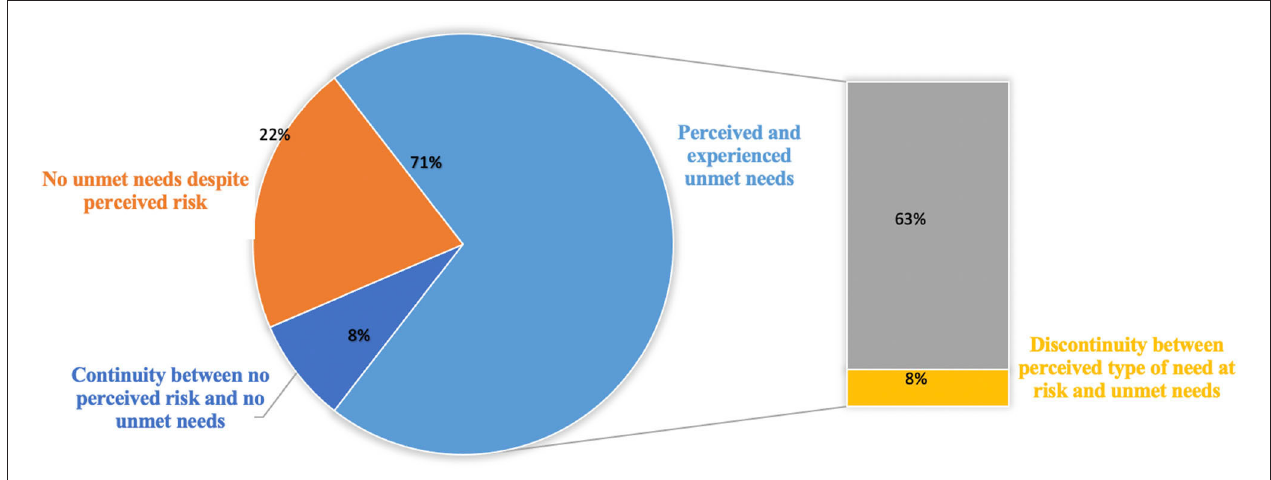
FIGURE 1 | Relationship between perceived and experienced needs during lockdown ( n =